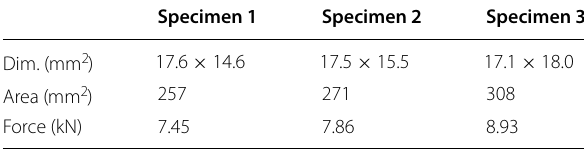
Table 2 Nominal parameters of AM sandwich